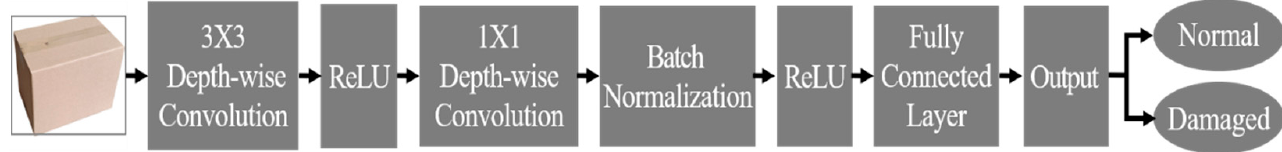
Figure 5. A flow chart for classification of parcel boxes.